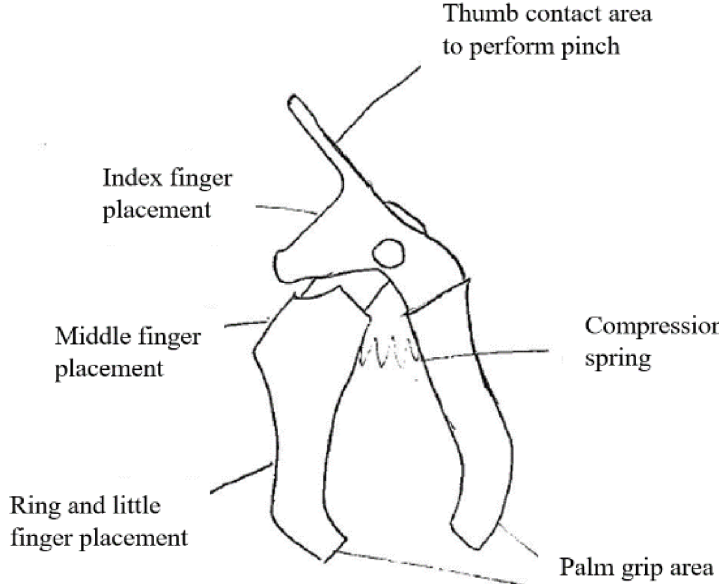
Figure 8. Dynamisation concept design.